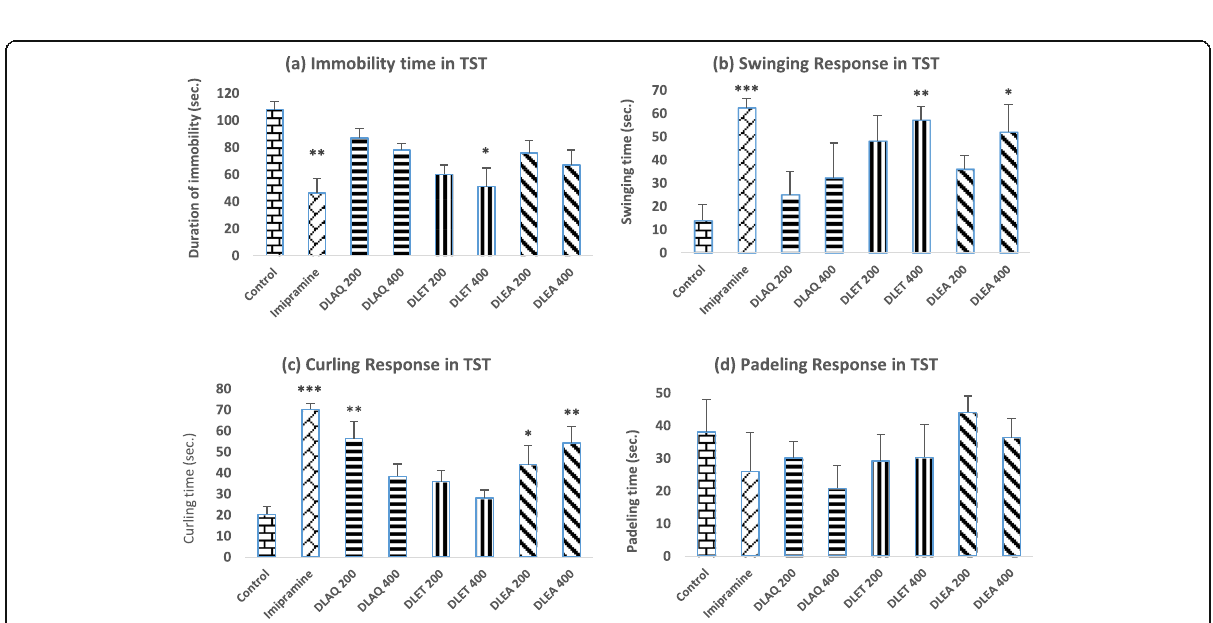
Fig. 3 a - d : Observation parameters of Tail Suspension Test (TST). Figure represented the duration of immobility ( a ), swinging response ( b ), curling time ( c ) and pedaling time ( d ) measured in seconds exhibited by the respective groups of mice. DLAQ = Aqueous extract of D. linearis , DLET = Ethanol extract of D. linearis , DLEA = Ethyl Acetate extract of of D. linearis . Data represented as mean + SEM and analyzed by one-way ANOVA followed by Dunnett t test where *, **, *** denoted p < 0.05, p < 0.01 and p < 0.001 respectively and statistically significant. All groups ( n = 6) were compared to